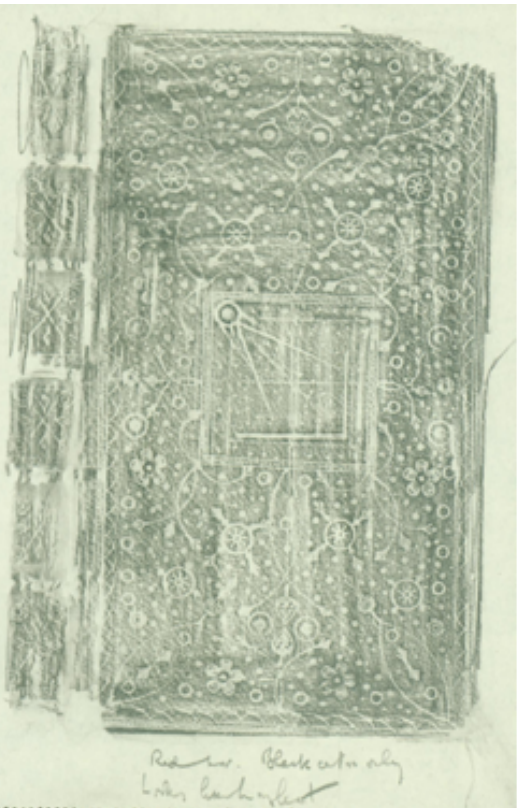
Fig. 5. Reproduction of rubbing taken by Howard Nixon. Note the masonic decoration on the centre piece achieved using generic bindings tools (not exact size). Copyright and reproduced by permission of the Museum of Freemasonry, London. BE 98 SMI.